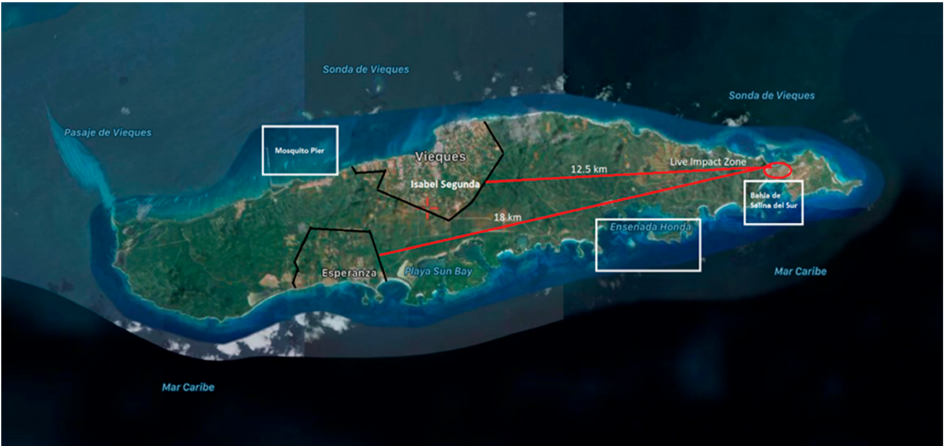
Figure 1. The island of Vieques used as a military bombing range. The live impact zone is illustrated with a red circle right above Bahia Salinas del Sur. Two big communities are located on the island, in the north (Isabel Segunda), which is about 12.5 km from the impact range (red line), and in the south (Esperanza), about 18 km from the live impact zone. The three white rectangles represent fishing areas where queen conch was collected for toxic metal